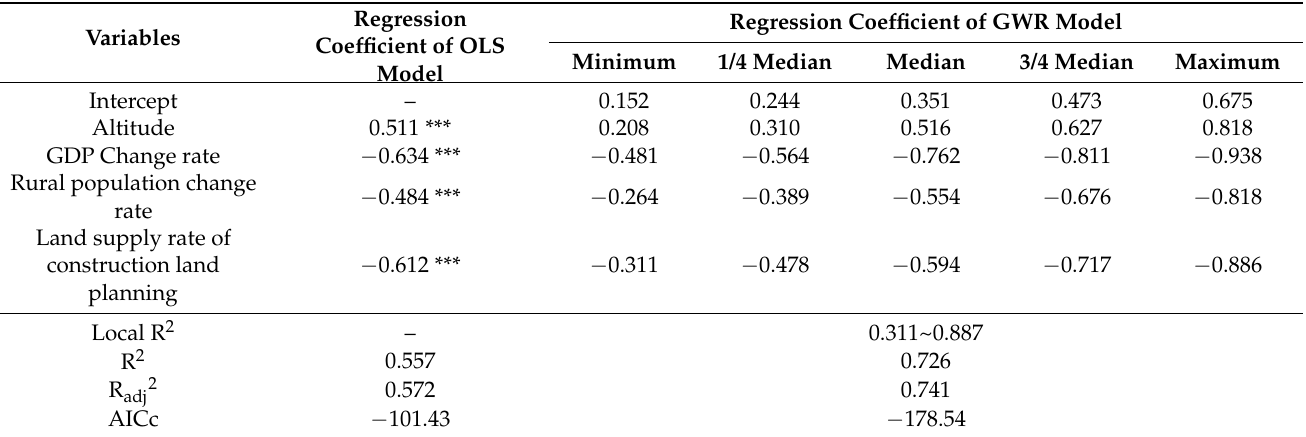
Table 6. GWR and OLS model estimation result for rural residential land